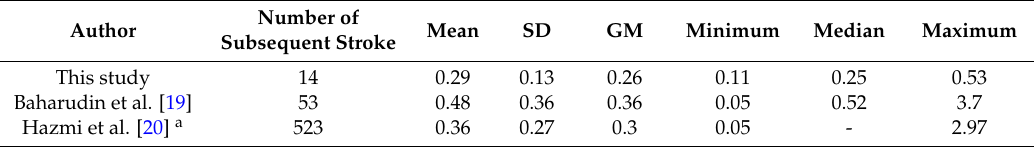
Table 5. Stroke amplitude